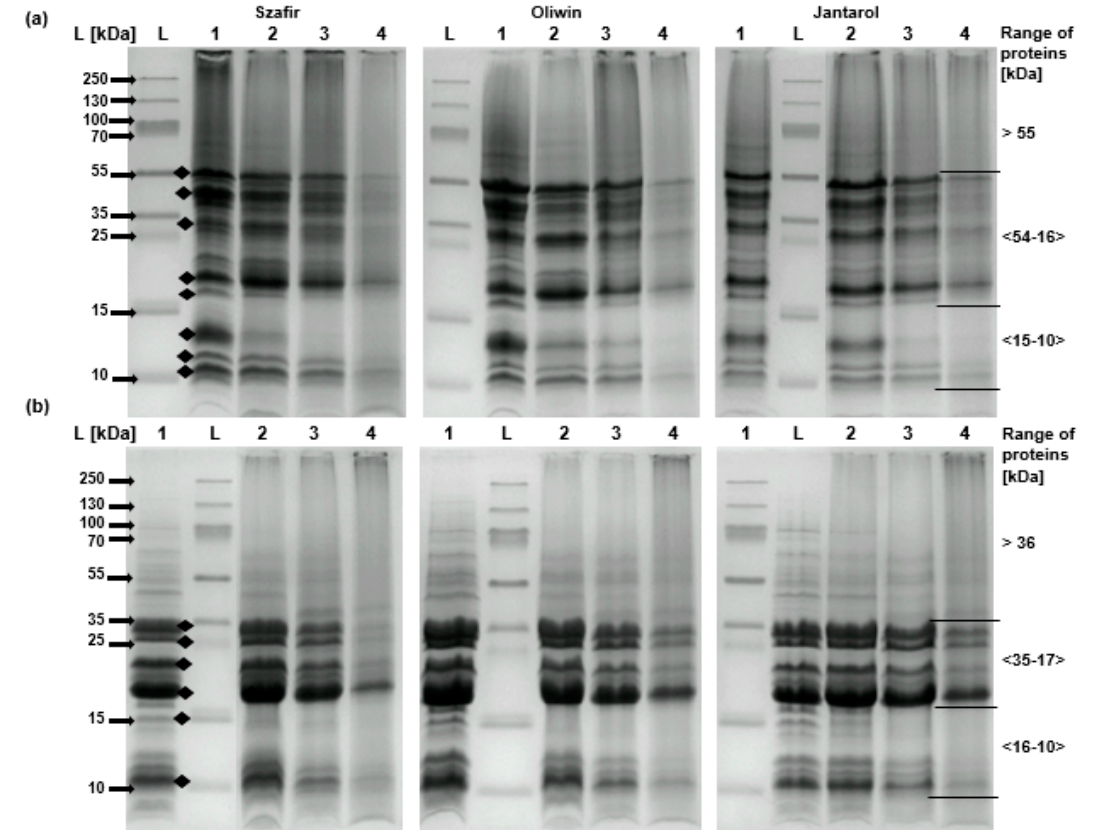
Figure 1. Analysis of untreated and thermal pretreated flaxseed samples by SDS-PAGE electrophoresis in non-reducing ( a ) and reducing ( b ) conditions. Line L—protein ladder (nine proteins spanning: 10, 15, 25, 35, 55, 70, 100, 130, and 250 kDa); 1—untreated; 2—roasted 160 ◦ C, 8 min; 3—roasted 180 ◦ C, 8 min; 4—roasted 200 ◦ C, 8 min. Black dots indicate major bands of the protein profile.